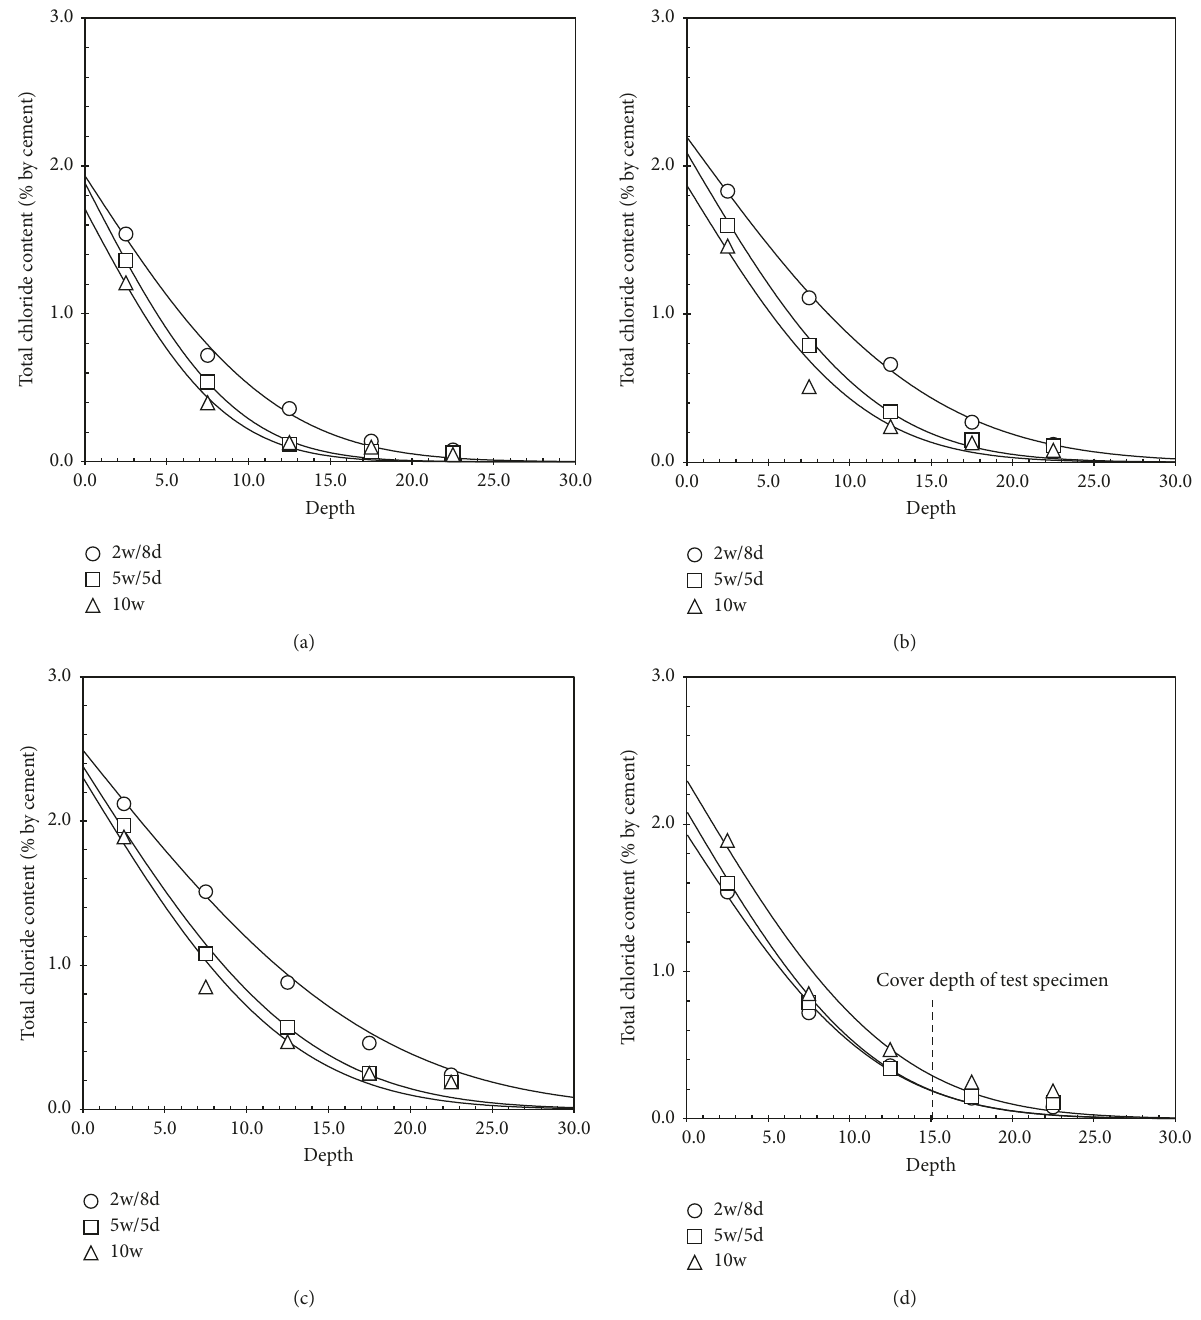
Figure 5: Chloride profile results at (a) 40, (b) 90, and (c) 160 days with different exposure condition, and (d) at the time when corrosion initiated. Table 1: Surface chloride and apparent chloride diffusion coefficients at 40, 90, and 160 days. Exposure